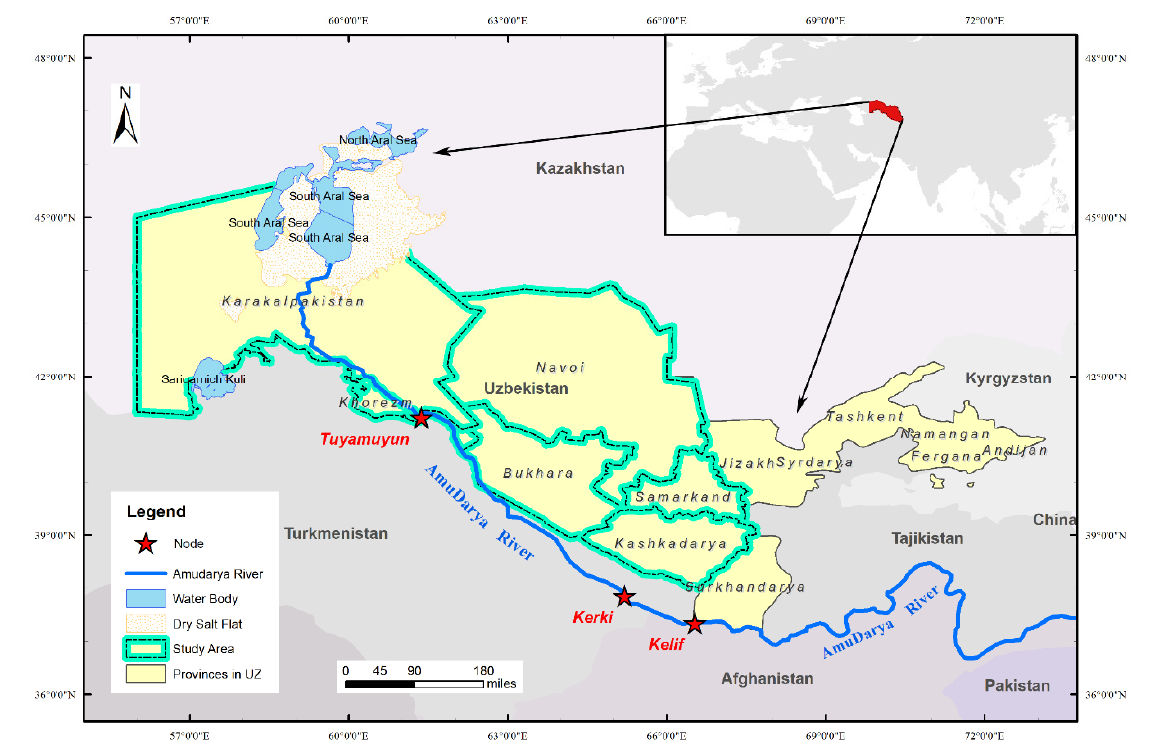
Figure 1. Study Figure 1. Study area.